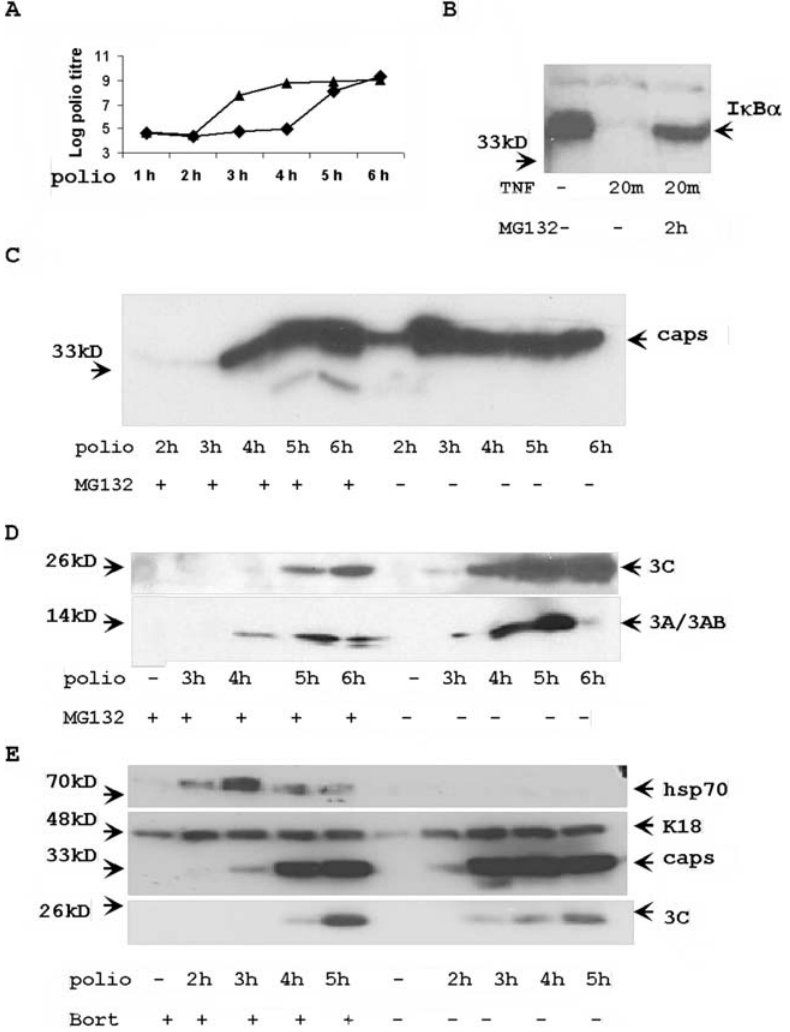
Figure 4. Proteasome inhibitors delay the replication of poliovirus. (A) HeLa cells (triangles) and HeLa cells pre-treated for 2 h with 5 m M proteasome inhibitor MG132 (squares) were infected with poliovirus strain Mahoney (MOI=5) for 1 h. After replacement of medium, the accumulation of virus in medium was estimated by titration. (B) MG132 inhibits TNF-specific degradation of I k B a . Control HeLa cells and HeLa cells pretreated with 5 m M MG132 for 2 h were incubated with 1 ng/ml of human TNF for 20 min. 10 m g of total protein extracts were analyzed with anti- I k B a Abs. (C) HeLa cells and HeLa cells pre-treated with MG132 were infected with poliovirus (MOI=5) for 1 h. After medium replacement, protein extracts were collected at different times of infection. The accumulation of poliovirus capsid proteins was tested in Western blotting experiments from 10 m g of protein extracts. (D) The protein extracts described in section B were tested with anti-proteins 3C and 3A Abs. The accumulation of poliovirus proteins 3C, 3A and 3AB were detected in 10 m g of protein extracts. (E) Bortezomib treatment attenuated poliovirus replication. HeLa cells were pretreated with Bortezomib for 2 h, then infected and analyzed as described in panels C and D. K18 was a loading control. Hsp70 is a control of Bortezomib